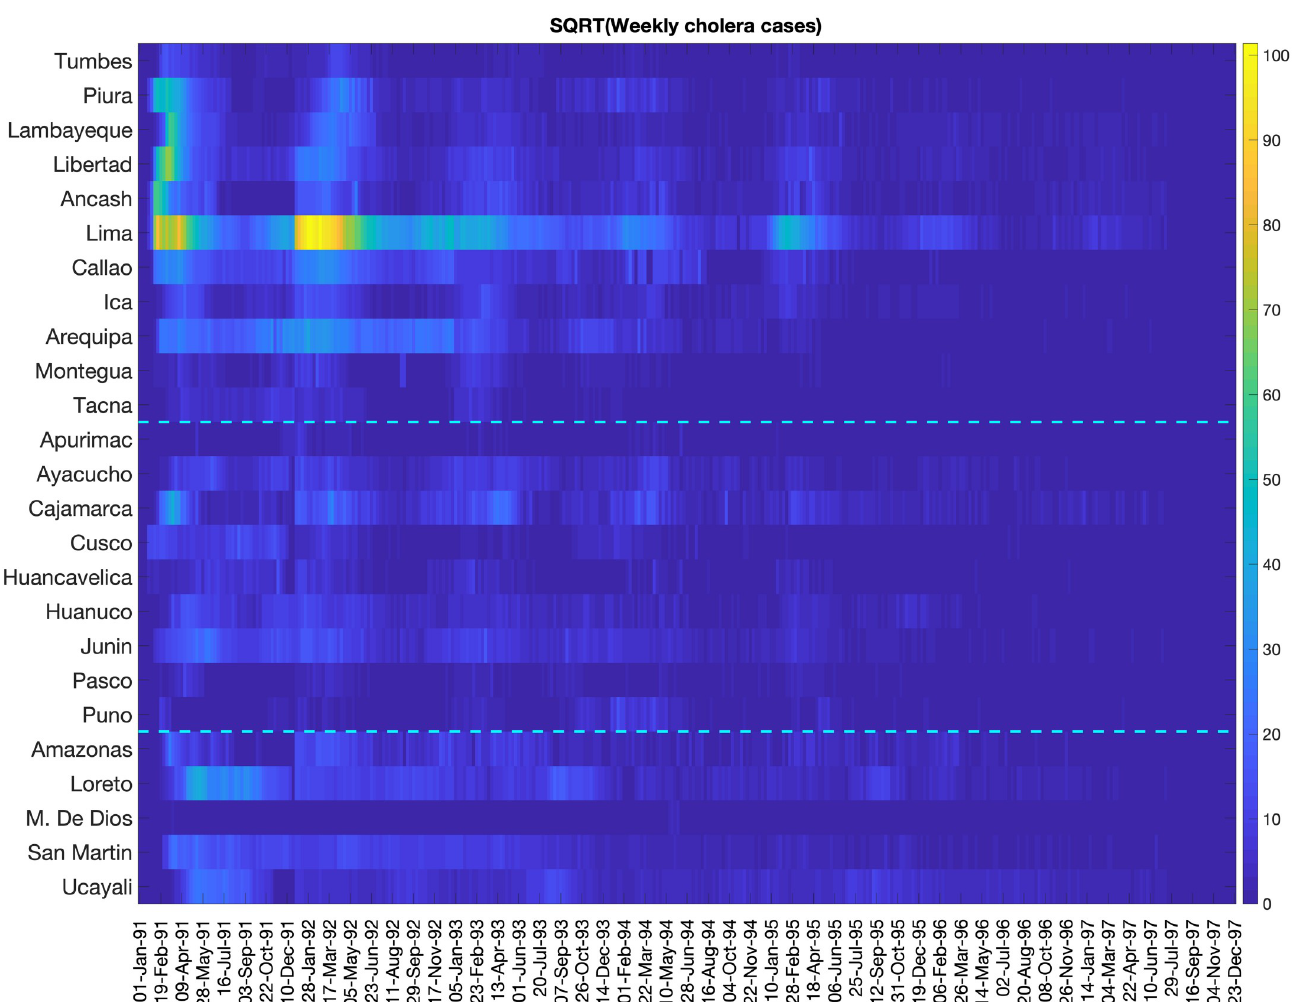
Fig 1. Color scale image of weekly cholera cases by department. Weekly cases have been square root transformed to reduce variability in the amplitude of the time series while dashed lines separate the coast, highland, and jungle regions. The epidemic hit the coastal departments early, with the highest case counts concentrated in this